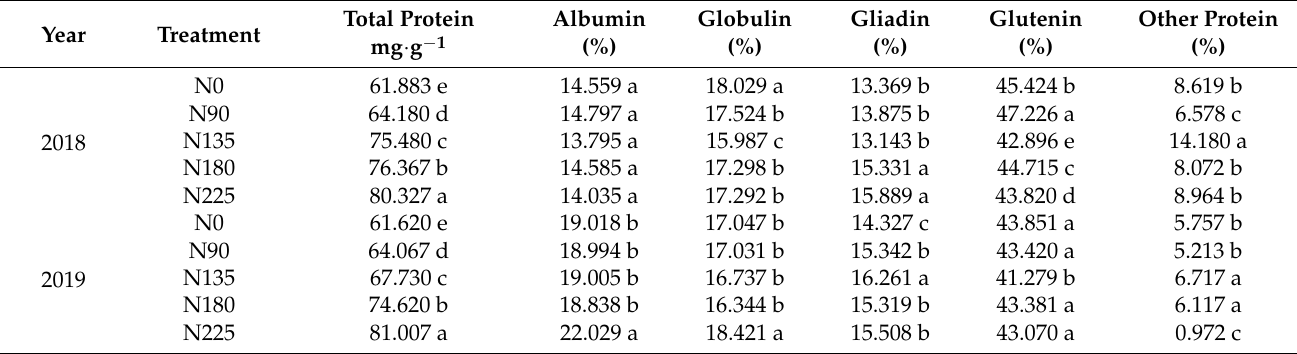
Table 5. Effect of different nitrogen application amount on the ratio of each component protein to total protein during maturity of low-gluten rice